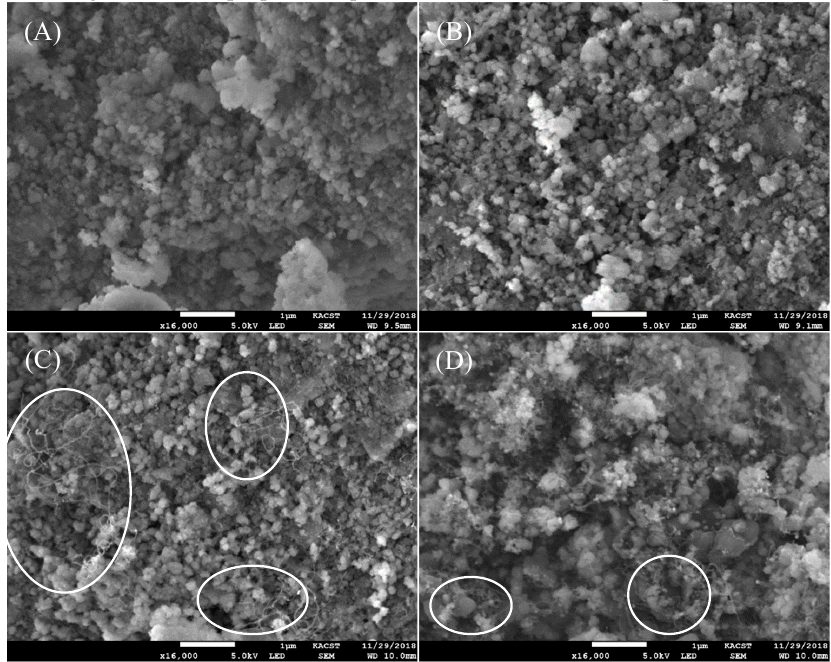
Figure 6. SEM micrographs for fresh catalysts ( A ) Ti-CAT-I, ( B ) Ti-CAT-II, and spent catalysts ( C ) Ti-CAT-I, ( D ) Ti-CAT-II. White circles are for some areas where CNTs are present.